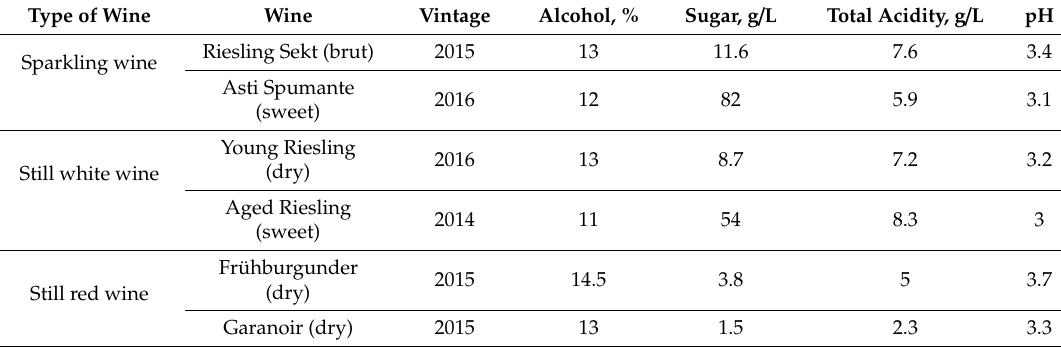
Table 1. Principal parameters of the commercial wines used for the sensory